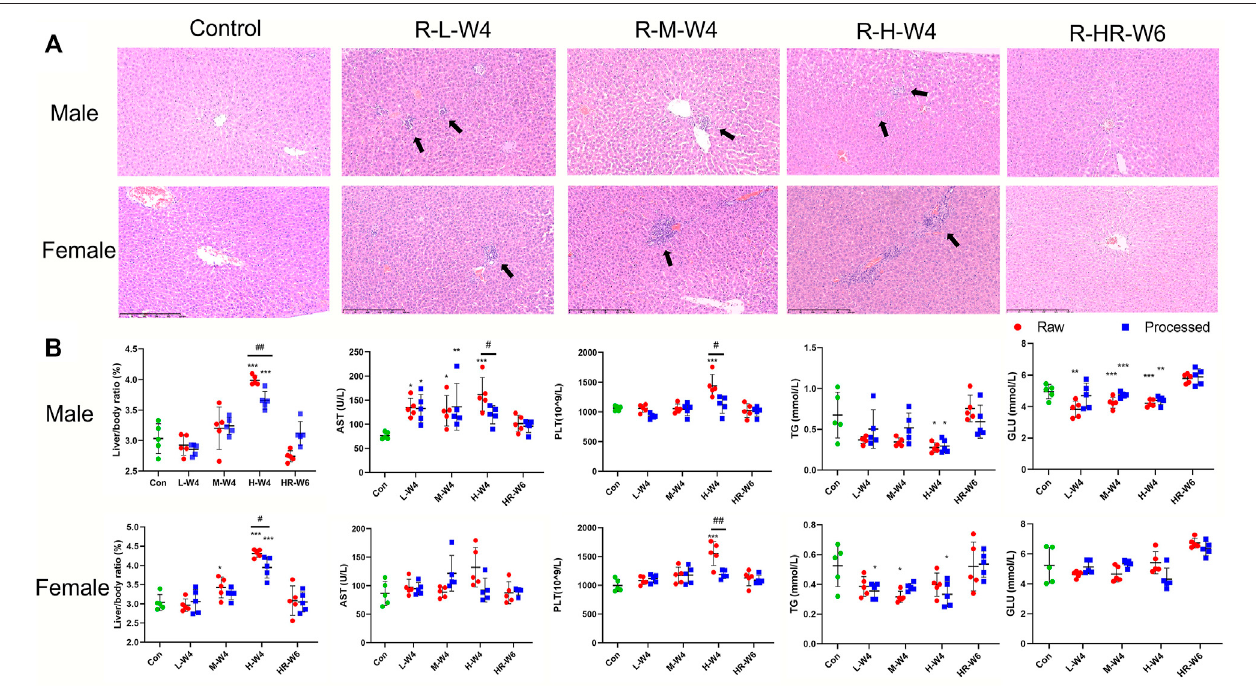
FIGURE1| TR-inducedhepatotoxicityinrats. (A) Typicalliverhistopathologicalresults(×100)ofmaleandfemaleratsintherawTRgroups(treatedwithrawTRfor 28 days; L, low dose; M, medium dose; H, high dose), recovery group (HR: treated with high-dose TR for 28 days and then 14-days recovery), and control group. (B) Typicalindicatorsofalterationsinbloodandserumbiochemistryafter treatmentwithrawandprocessedTR.Dataareexpressedasmeans±standardderivation(n=5). * p < 0.05, ** p < 0.01, *** p < 0.001 compared with the control group.